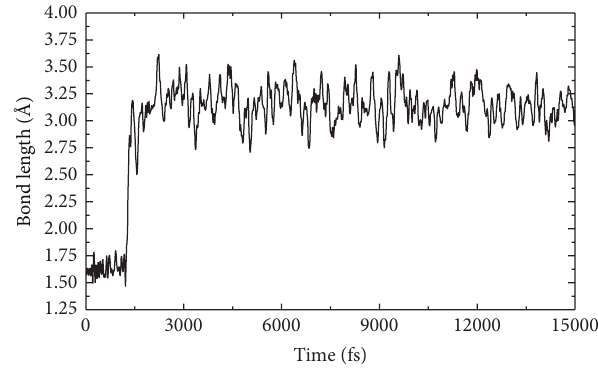
Figure 5: Variations with time of C 1 –C 2 bond of cis-SP following application of a 80 fs (FWHM) laser pulse with a fluence of 0.186 kJ/m 2 and photon energy of 4.054 eV and excited state lifetime of 254